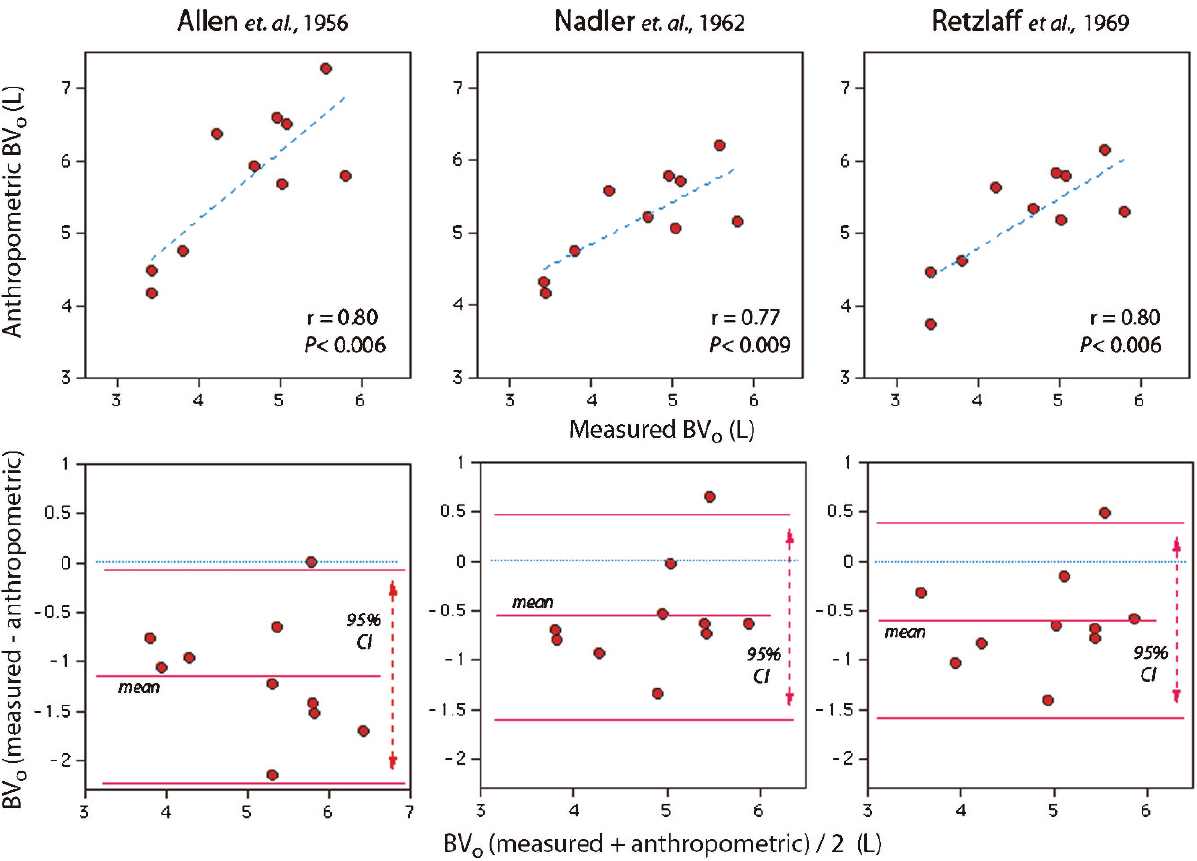
Figure 4 - Correlations (top row) and Altman-Bland tables (bottom row) comparing blood volume measured with a kinetic technique (BV 0 ) with values obtained by